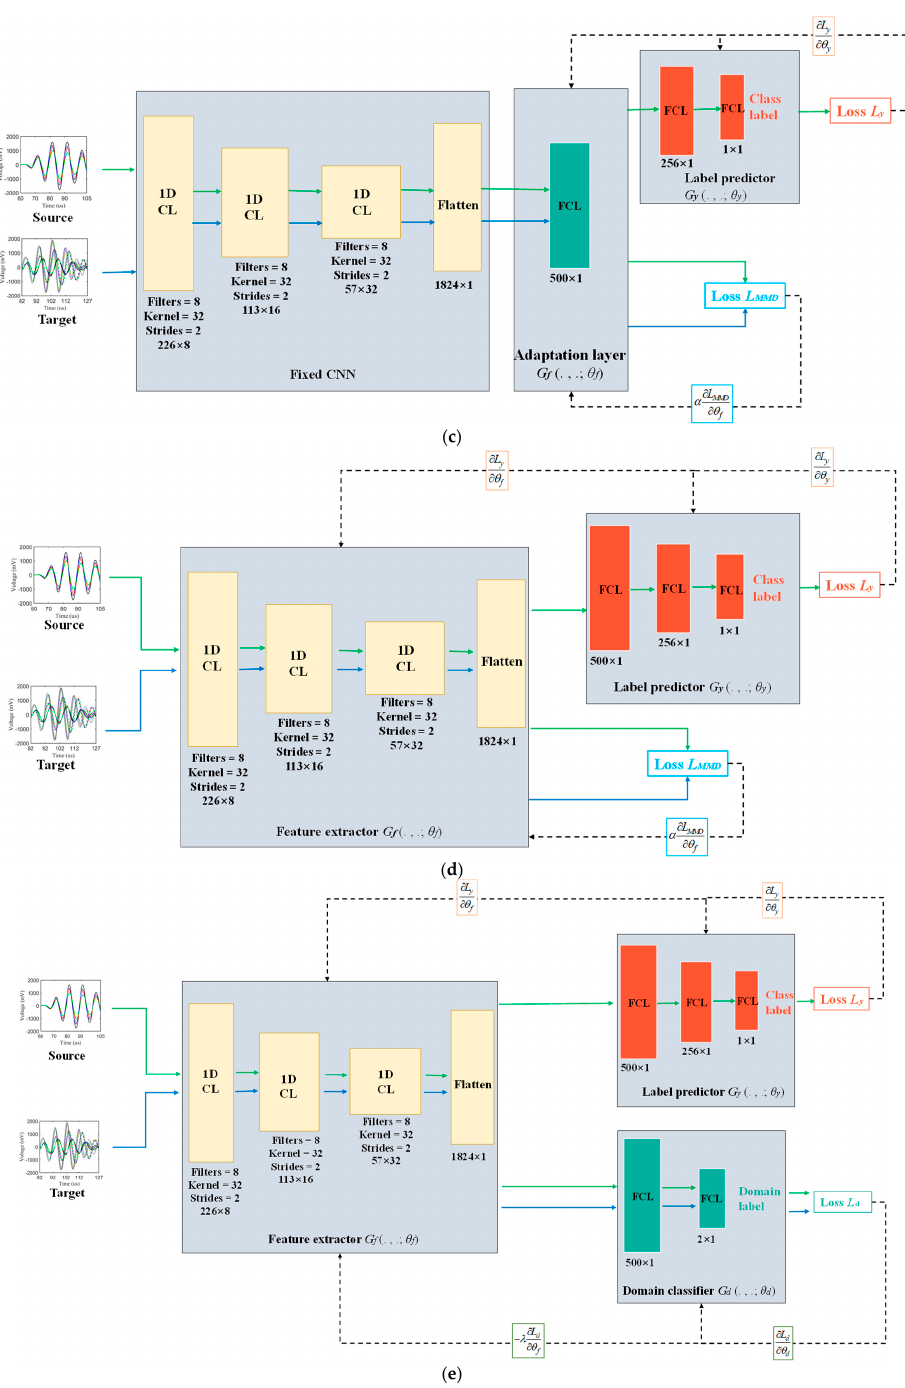
Figure A1. The architectures of ( a ) 1D-CNN, ( b ) WGAN-GP, ( c ) DAC, ( d ) DAN, and ( e ) DANN model used in the